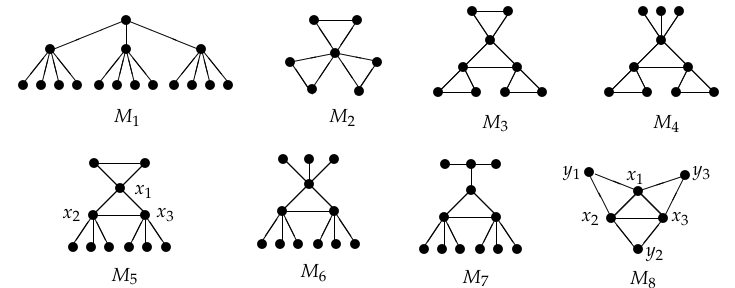
Figure 2. Eight special 4-cutwidth critical